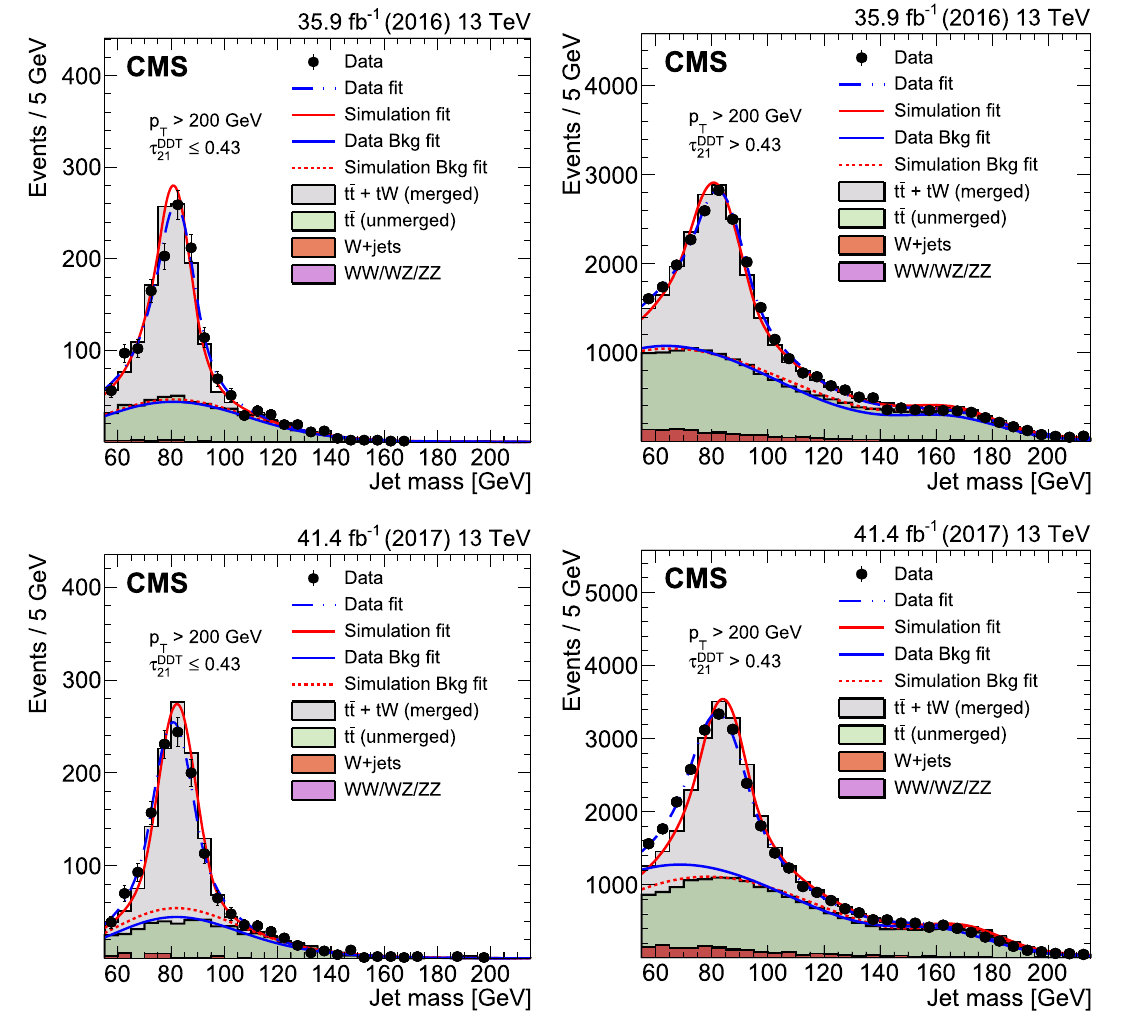
Fig. 5 Thejetmassdistributionforeventsthatpass(left)andfail(right) ≤ 0 . 43 selection in the t ¯ t control sample. The results of the the τ DDT 21 separate fits to data and to simulation are shown by the dash-dotted blue and solid red lines, respectively. The background components of